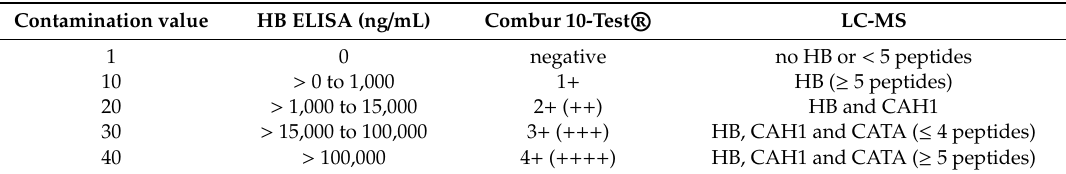
Table 2. Categorization of blood contamination in CSF. For each method, five specific contamination levels were selected on the basis of visual read out (for the Combur10-Test ® strips), detection of specific blood proteins (for LC-MS analysis), and defined hemoglobin concentrations (for ELISA). Contamination value HB ELISA (ng / mL) Combur 10-Test ®